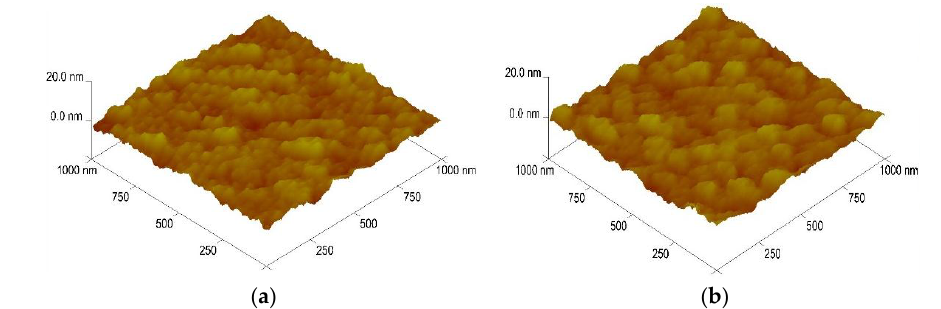
Figure 2. Atomic force microscopy (AFM) analysis of the GZO thin films as a function of substrate at room temperature. ( a ) Glass and ( b ) PI, respectively.